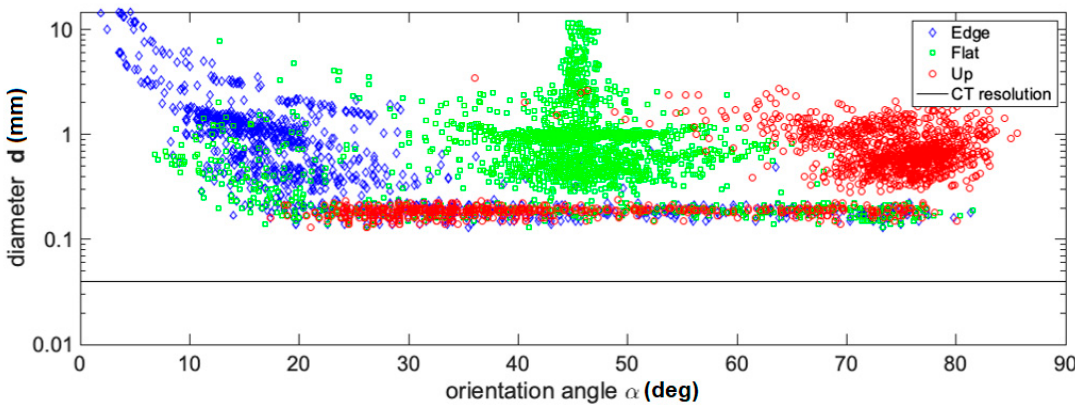
Figure 7. Void size ( d ) and orientation angle ( α ) relation. The black line indicates the CT resolution limit due to the used parameters and sample size.